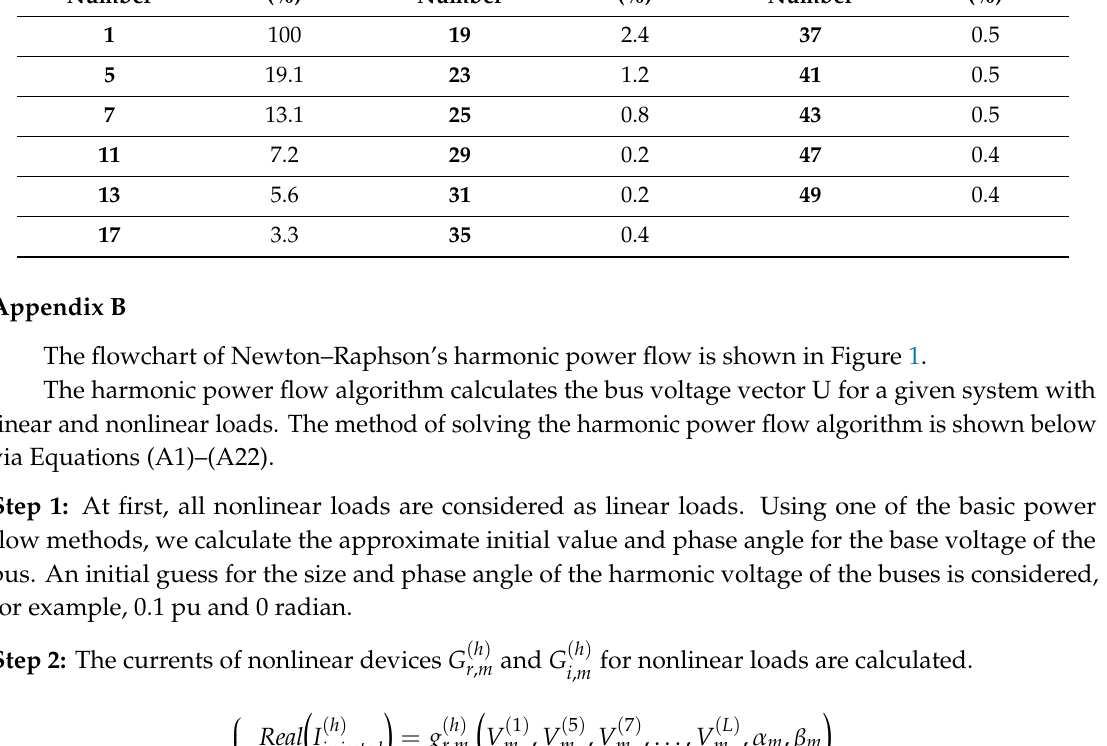
Table A3. The harmonic current size as a percentage of the basic current for the six-pulse converter. Harmonic Amplitude Harmonic Amplitude Harmonic Amplitude Number (%) Number (%) Number (%) 1 100 19 2.4 37 0.5 5 19.1 23 1.2 41 0.5 7 13.1 25 0.8 43 0.5 11 7.2 29 0.2 47 0.4 13 5.6 31 0.2 49 0.4 17 3.3 35